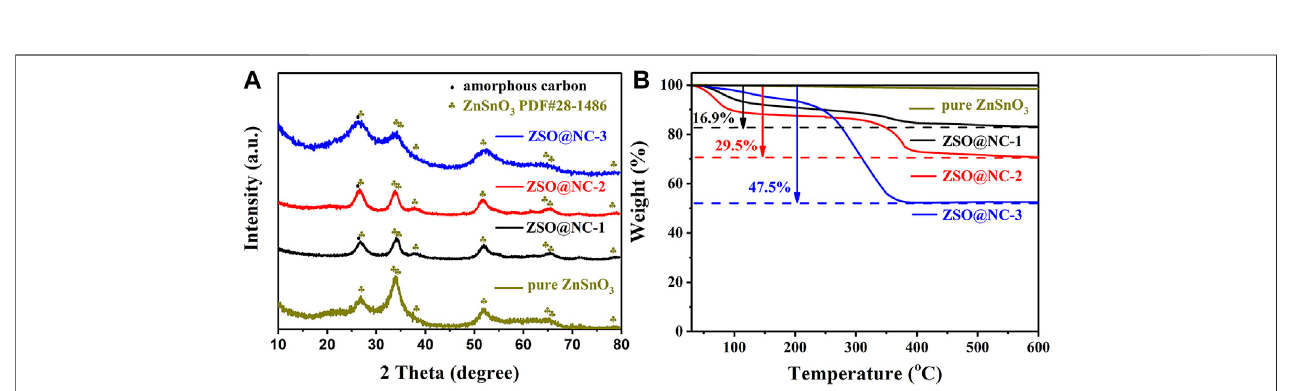
FIGURE 2 | XRD patterns (A) and TGA curves (B) of the ZSO@NC-(1,2,3) and pure zinc stannate (ZnSnO 3).